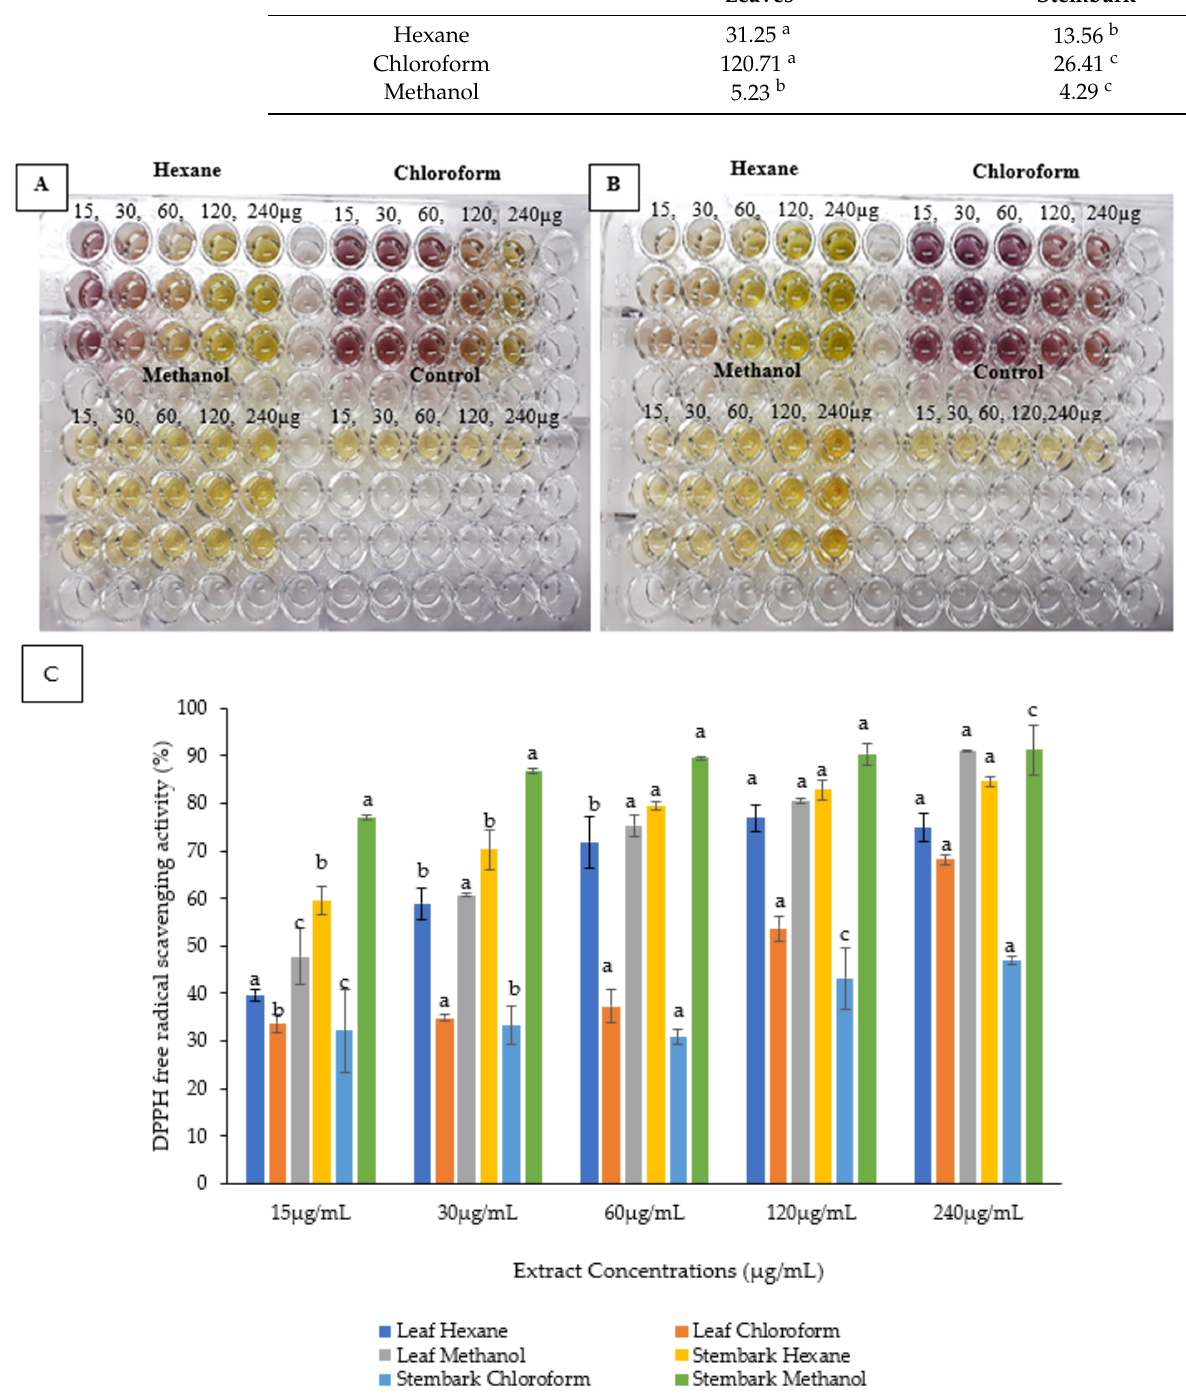
Figure 1. DPPH free radical scavenging activity of the C. erythrophyllum leaf and stembark extracts extracted in hexane, chloroform, and methanol. Microplates with wells containing the reaction mixture and different concentrations of each of the ( A ) leaf and ( B ) stembark extracts. The positive control was ascorbic acid. ( C ) DPPH free radical scavenging activity (%) compared to the control for each extraction solvent and each leaf or stembark extract concentration. a–c letters above the bars indicate significantly different data (Tukey’s honest significant difference multiple range post hoc test, p < 0.05).